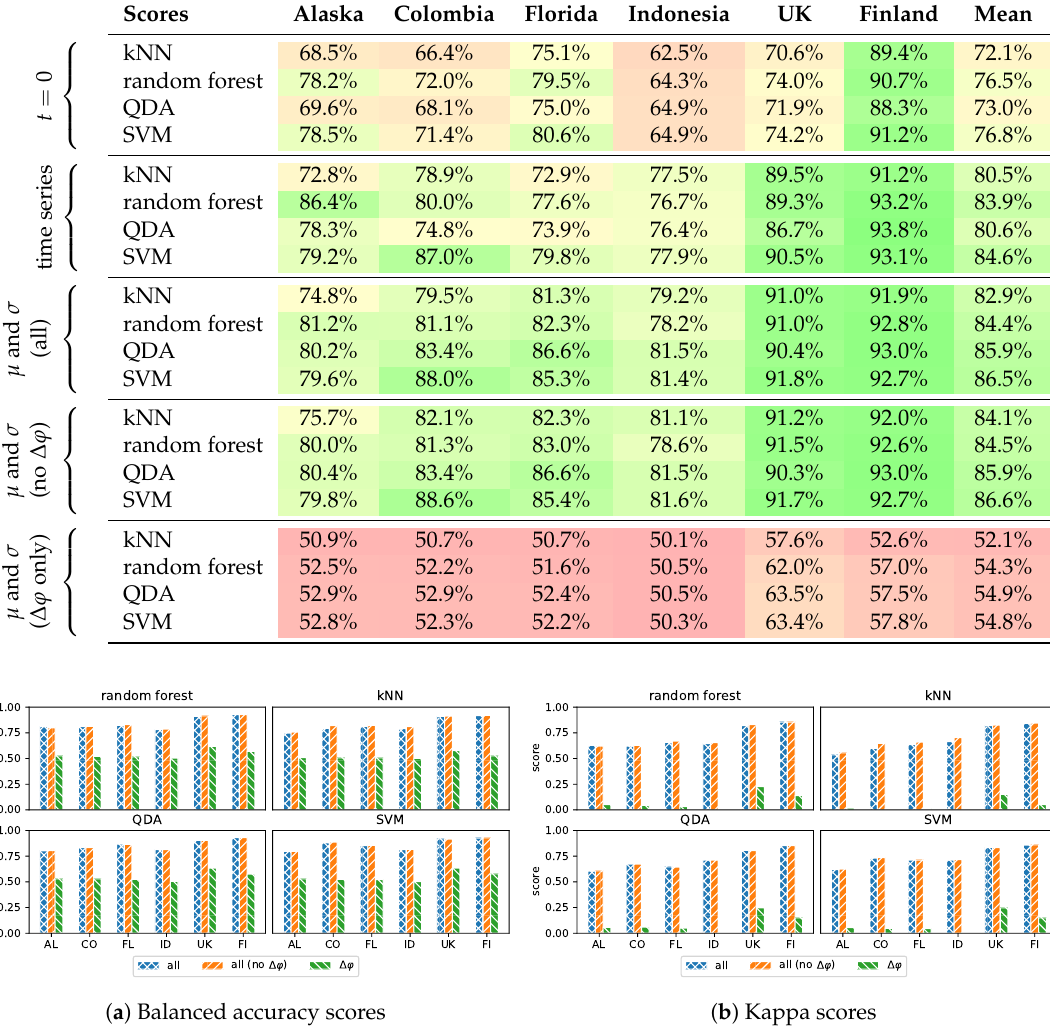
Table 2. This table summarizes the balanced accuracy scores from Figure 7 and equivalent outcomes from using a single time step or the entire time series. The variables used for classification are VV and VH backscatter as well as the VV-VH phase difference ( ∆ ϕ ). The rows differ in whether these variables were considered for a single time step ( t = 0), the entire time series, or the mean and standard deviation ( µ and σ ) of the time series, and whether or not they include the phase difference. The table is color coded on a linear scale; with green, yellow, and red corresponding to accuracy scores of 100%, 75%, and 50%, respectively.